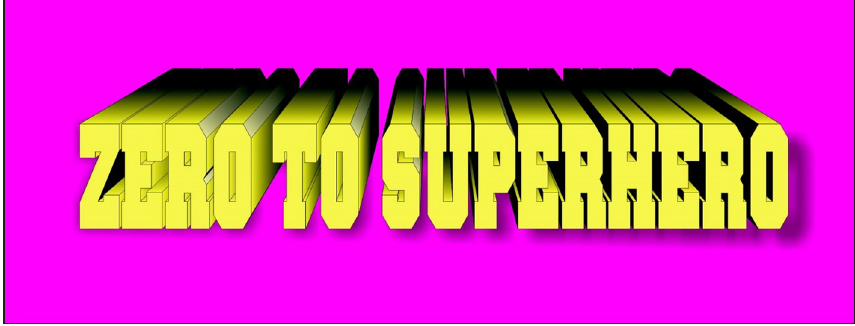
Figure 2: Start Up Pop Up Ltd 2013 Zero to Superhero , Trade mark no UK0000 3017203, © Start Up Pop Up Ltd